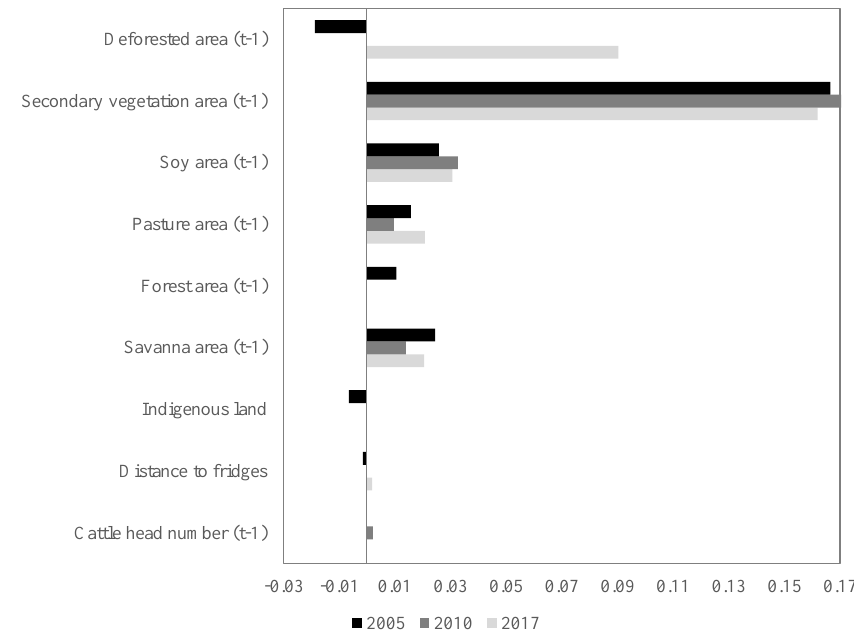
Figure 4. Standardized regression coefficients for pasture expansion models of 2005, 2010, and 2017, significant at p ≤